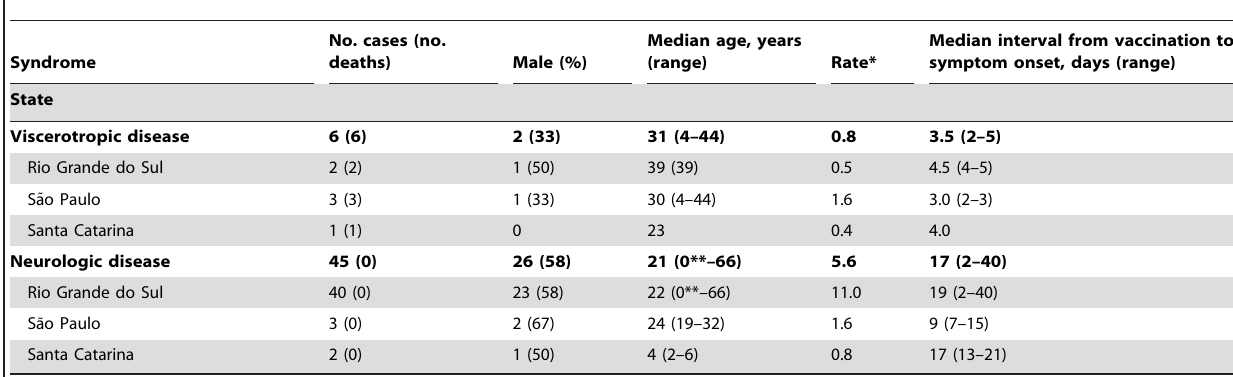
No. cases (no. deaths) Male (%)